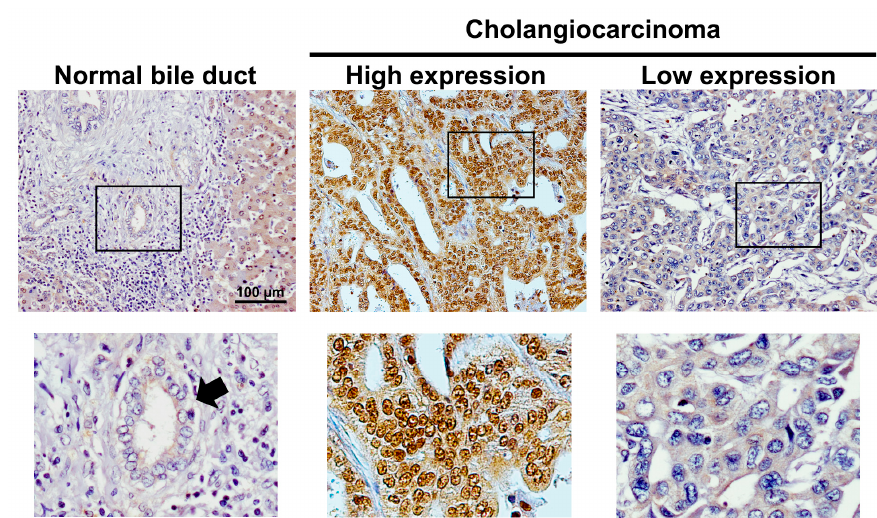
Figure 1. Expression patterns of IRS1 in normal bile ducts and CCA tissues determined using immuno- histochemistry. All figures on the upper panel were taken at 100 × magnification. Squares represented areas of the top row that were enlarged in the bottom row. Arrow indicates normal bile duct. Table 1 . The association between IRS1 expression patterns and clinicopathological features of CCA patients .